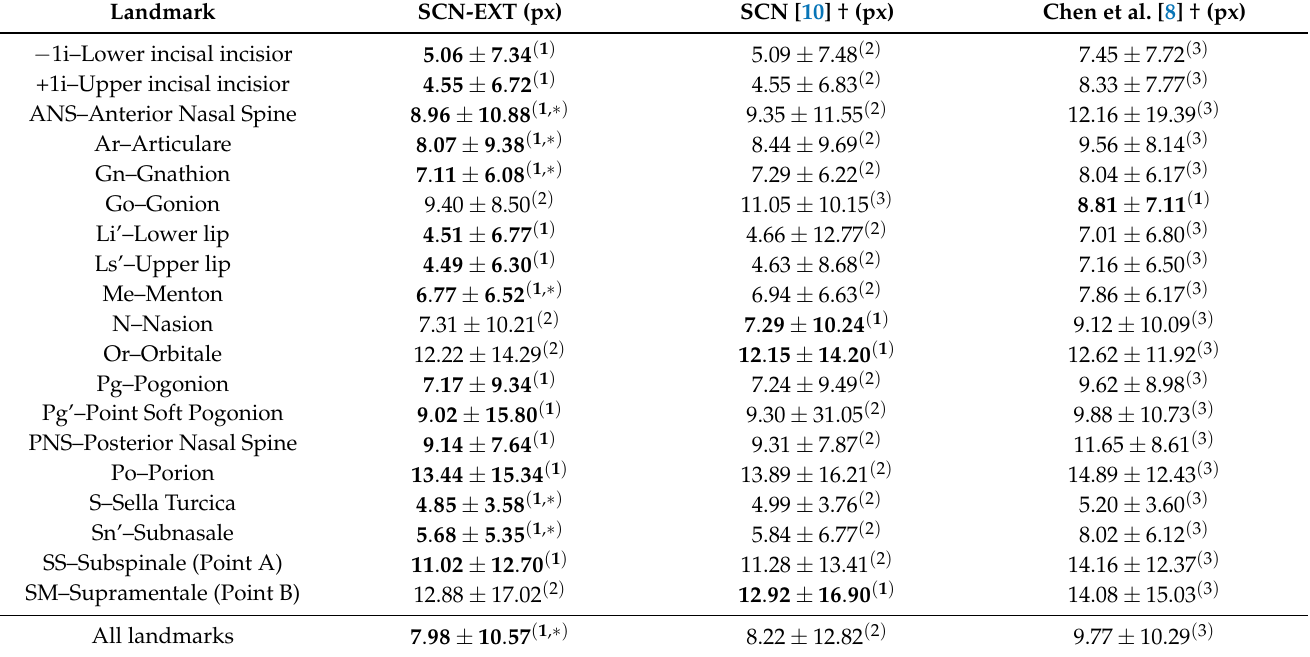
Table 7. Effectiveness of the compared methods on the AUDAX database. Considered are only landmarks from the ISBI database. The mean and standard deviation of the radial error are presented in pixels. A number and * in () denote the method’s rank and statistically significant difference. Better results are marked in